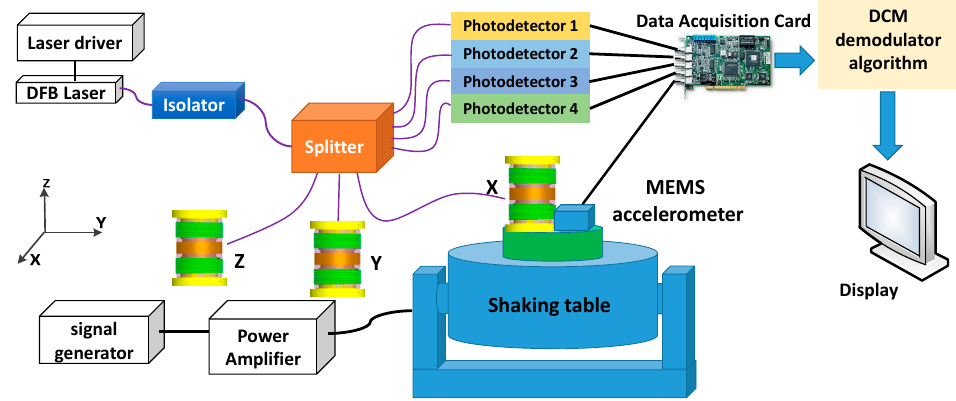
Figure 8. Equipment of experiment system for vibration measurement.